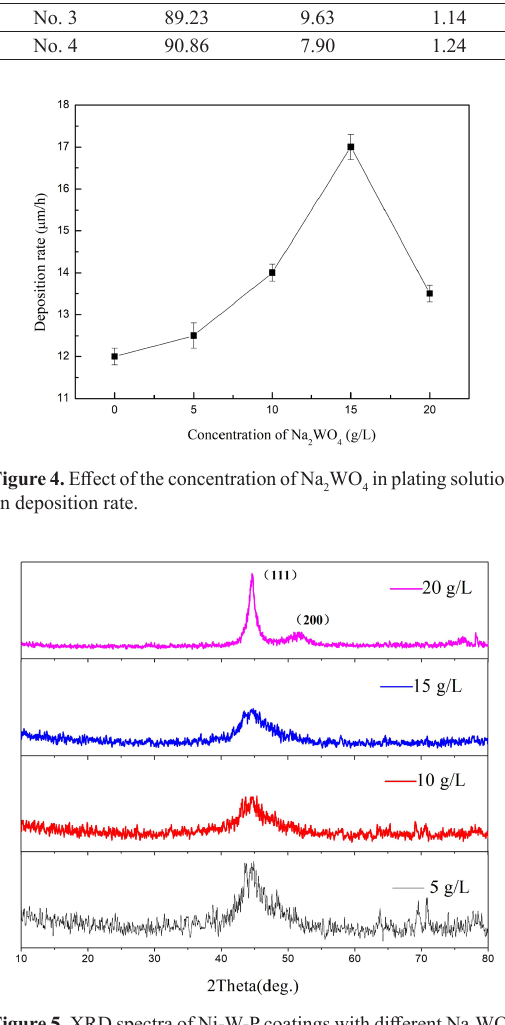
Figure 5. XRD spectra of Ni-W-P coatings with different Na concentrations in plating solution.